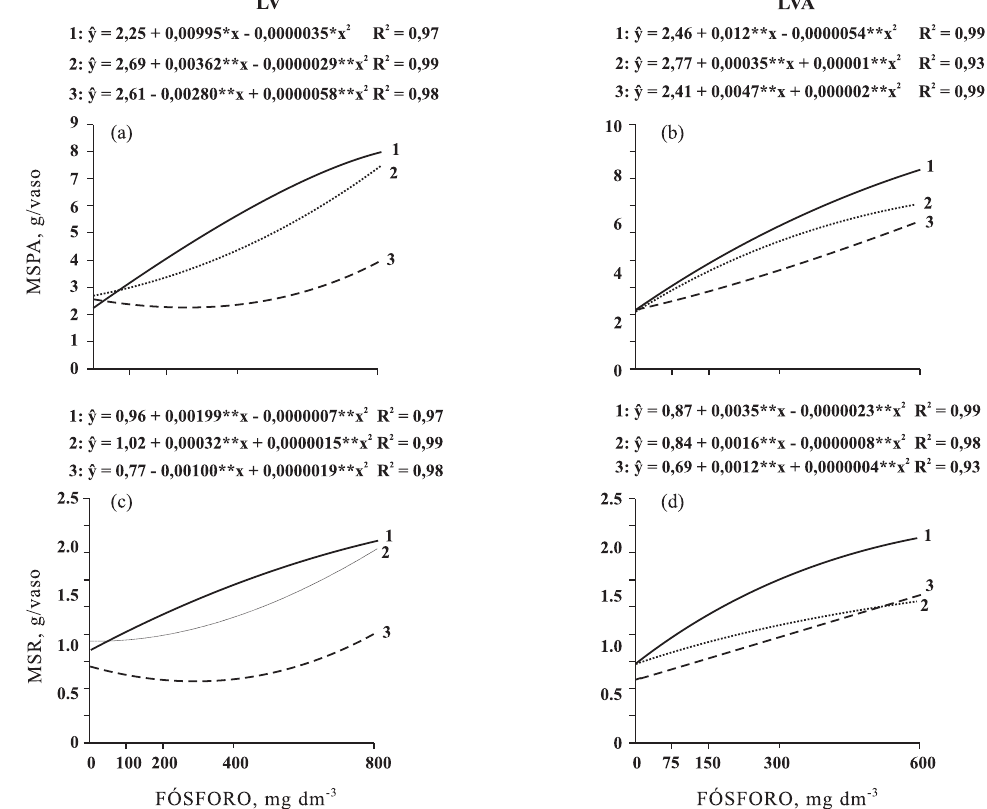
Figura 1. Matéria seca da parte aérea (a, b) e das raízes (c, d) da soja cultivada no LV e LVA em função das doses de fósforo, de acordo com cada densidade (LV: 1=0,90, 2=1,10 e 3=1,30 kg dm -3 ; LVA: 1=1,30, 2=1,50 e 3=1,70 kg dm -3 ) (** e *: significativos a 1 e 5 %, respectivamente, pelo teste